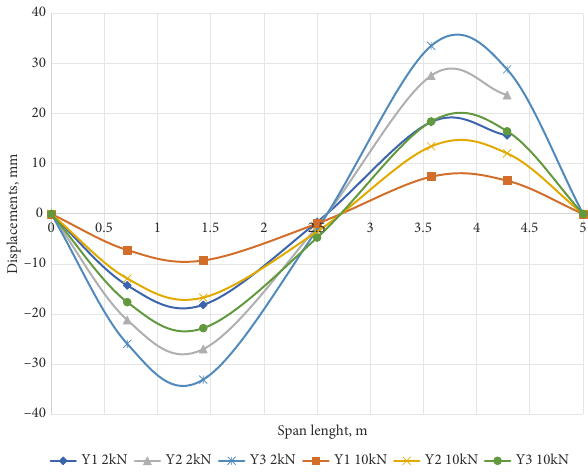
Figure 7. Displacements results of the numerical test of the combined string structure, when string pre-tension is 2 and 10 kN